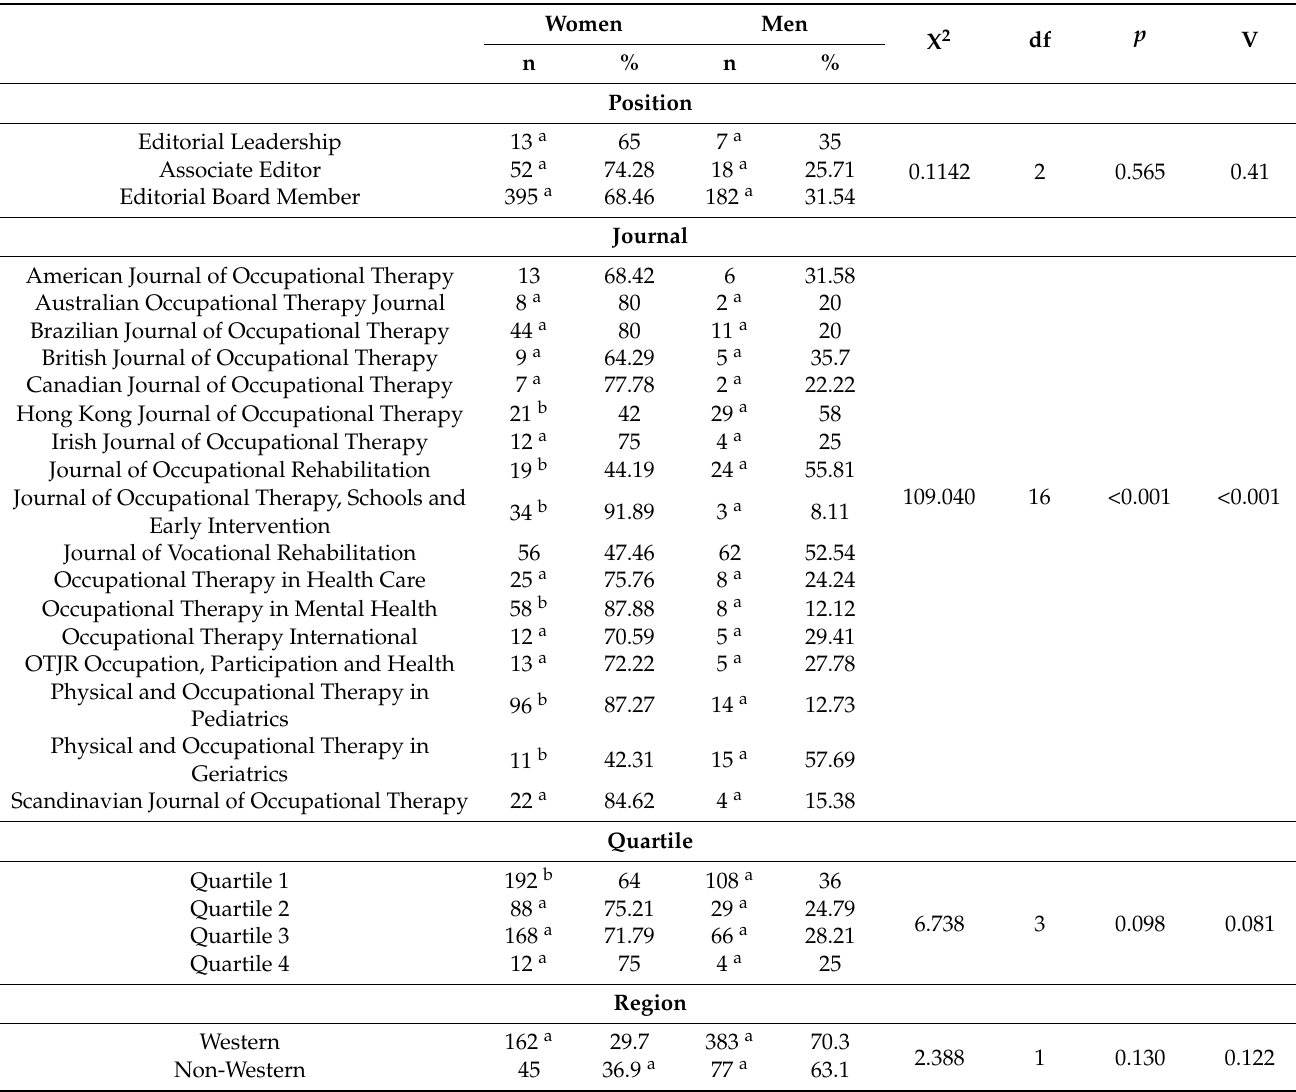
Table 6. Contingency table by genre and editorial position, quartile, journal, and